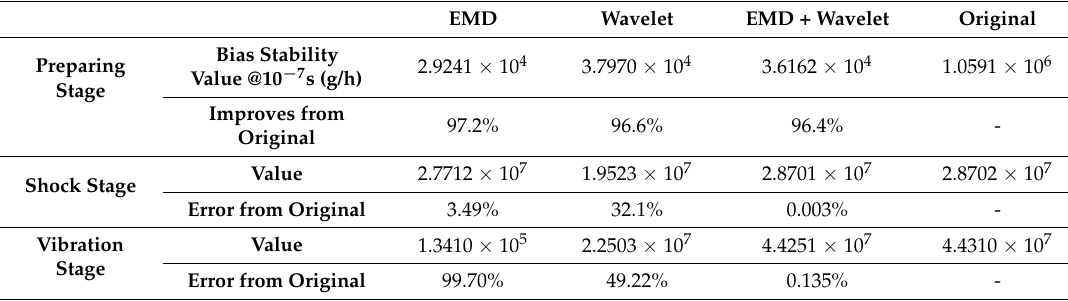
Table 3. Comparison of three denoising algorithms.